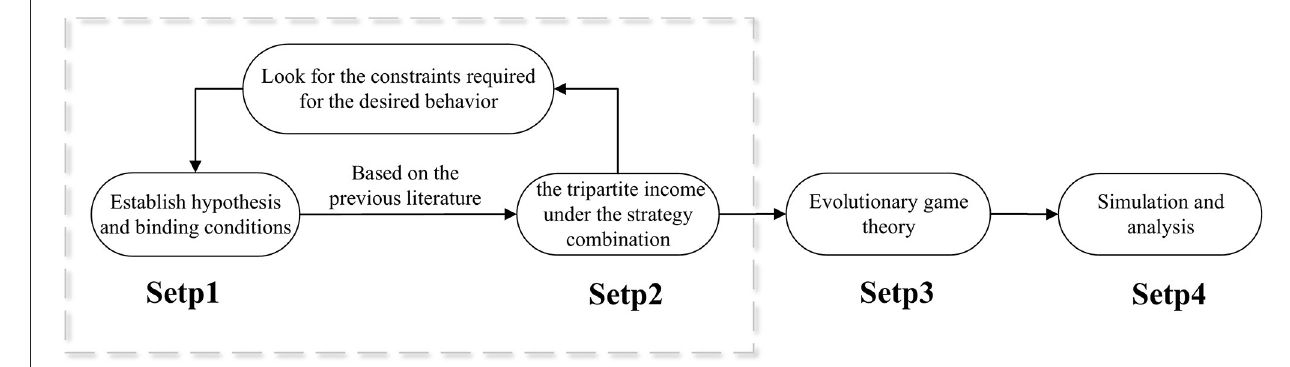
FIGURE 1 | Model frameworks.